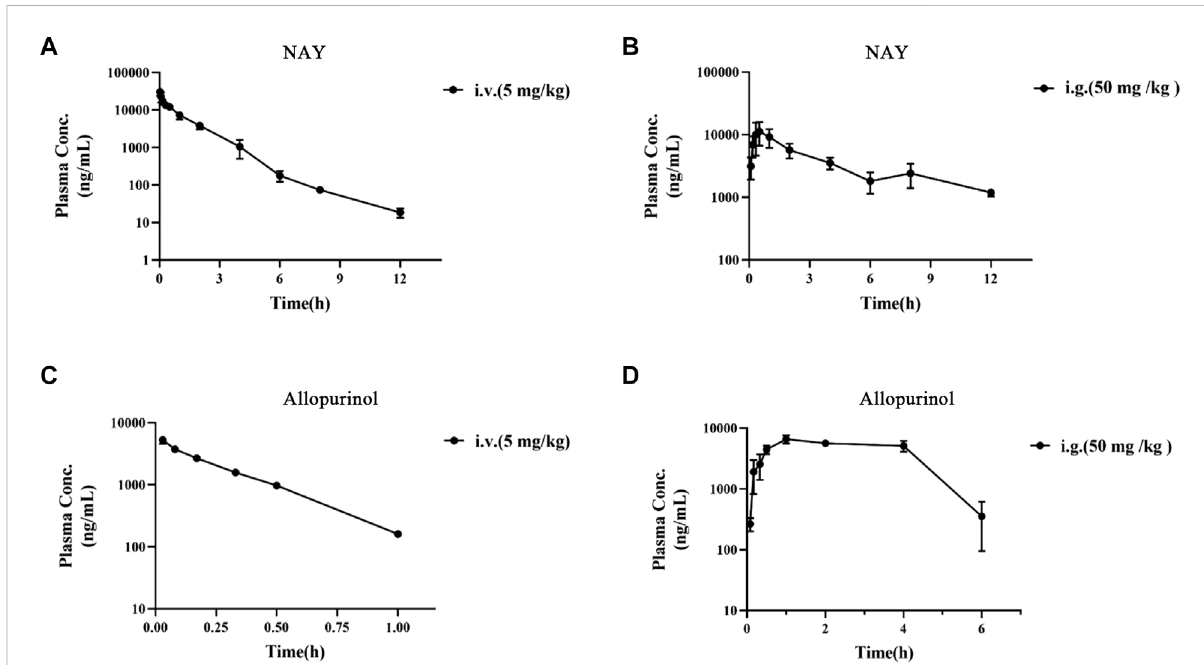
FIGURE 13 (A) : Blood concentration – time curve of NAY (5 mg/kg) intravenously injected in rats ( n = 3). (B) : Blood concentration – time curve of NAY (50 mg/kg) after intragastricadministration inrats ( n = 3). (C) :Blood concentration – time curve ofallopurinol (5 mg/kg) intravenously injected in rats ( n = 3). (D) : Blood concentration – time curve of allopurinol (50 mg/kg) after intragastric administration in rats ( n = 3).